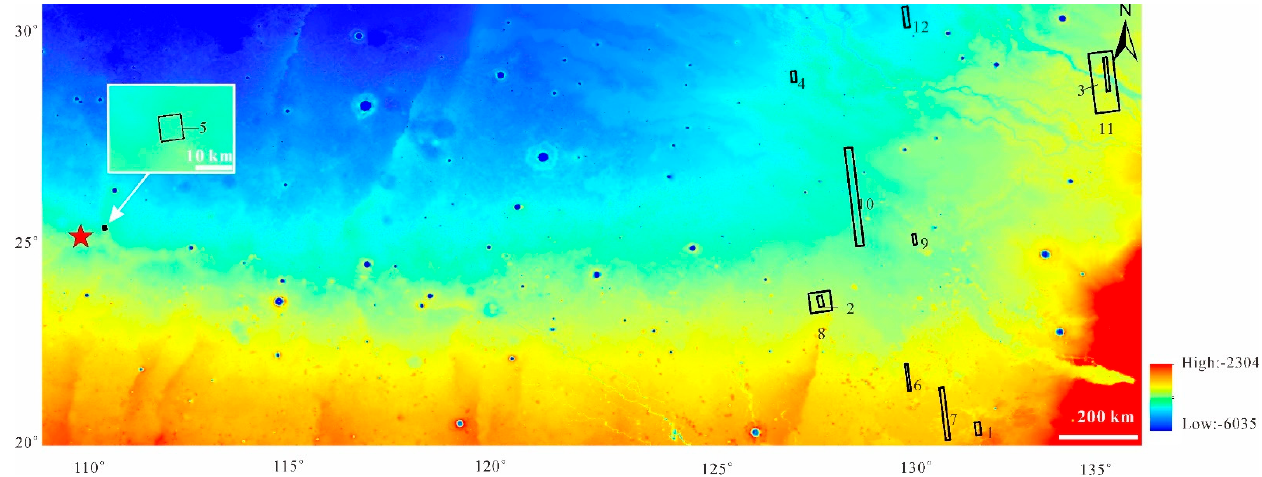
Figure 2. The study area is in southern Utopia Planitia. HiRISE image pairs 15 and CTX image pairs 612 are indicated by black boxes. Image pairs 2 and 8 and 3 and 11 are overlapped. Background: The rendered elevation map. The red five-pointed star represents the landing site of Tianwen-1.